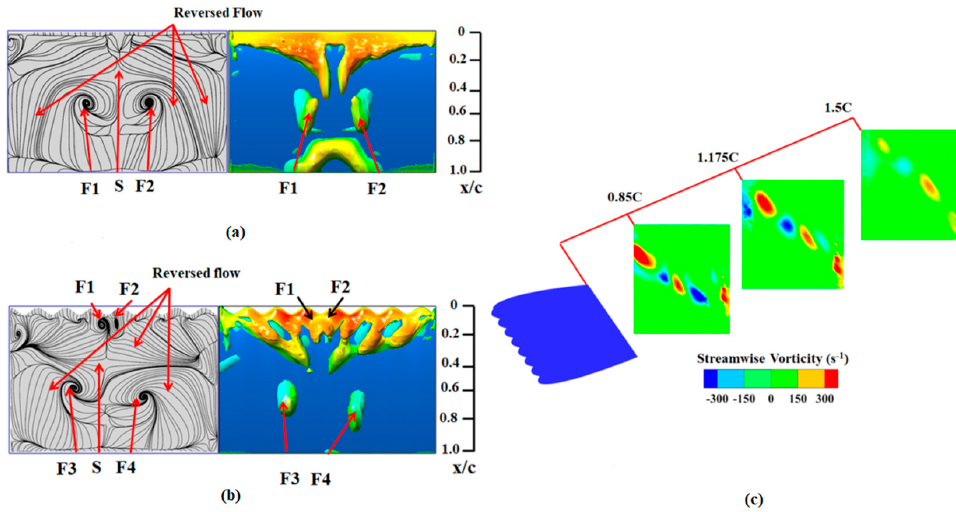
Figure 10. Contours of streamwise vorticity with shear stress lines. ( a ) Shear stress lines for baseline at 18 ◦ ↑ ; ( b ) Shear stress lines for R = 1.0 at 18 ◦ ↑ ; ( c ) Contours of streamwise vorticity.